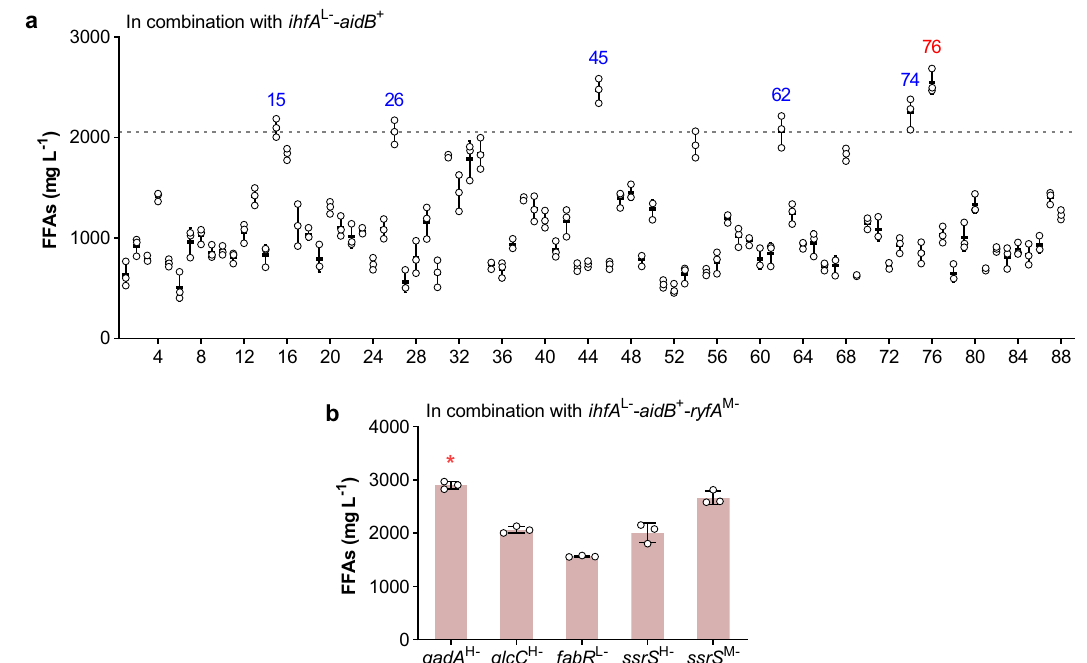
Fig. 7 Combinatorial genetic perturbation for improved FFAs production. a FFAs production of ihfA L − - aidB + in combination with each bene fi cial sgRNA. The gray line represents the FFAs titer of the ihfA L − - aidB + strain. Numbers 1 to 88 represent the sgRNA gpsA H − , plsY H − , pgpB H − , pgpC H − , pfkA H − , pykF H − , dld H − , pta H − , yccX H − , eutE H − , bioC H − , bioH H − , bioD H − , gabD H − , gadA H − , fadE H − , fadB H − , atoB H − , yqeF H − , fabR H − , fadR H − , asnC H − , fnr H − , cra H − , gadW H − , glcC H − , glpR H − , ihfB H − , torR H − , gpsA M − , yccX M − , bioC M − , gadA M − , atoB M − , cra M − , glpR M − , gpsA L − , pfkA L − , pta L − , bioH L − , bioD L − , gabD L − , gadA L − , atoB L − , fabR L − , asnC L − , cra L − , glp R L − , norR H − , nrdE H − , npr H − , yihU H − , glpG H − , ftsQ H − , creC H − , sdhB H − , pal H − , rplW H − , tyrU H − , csrC H − , rnpB H − ,